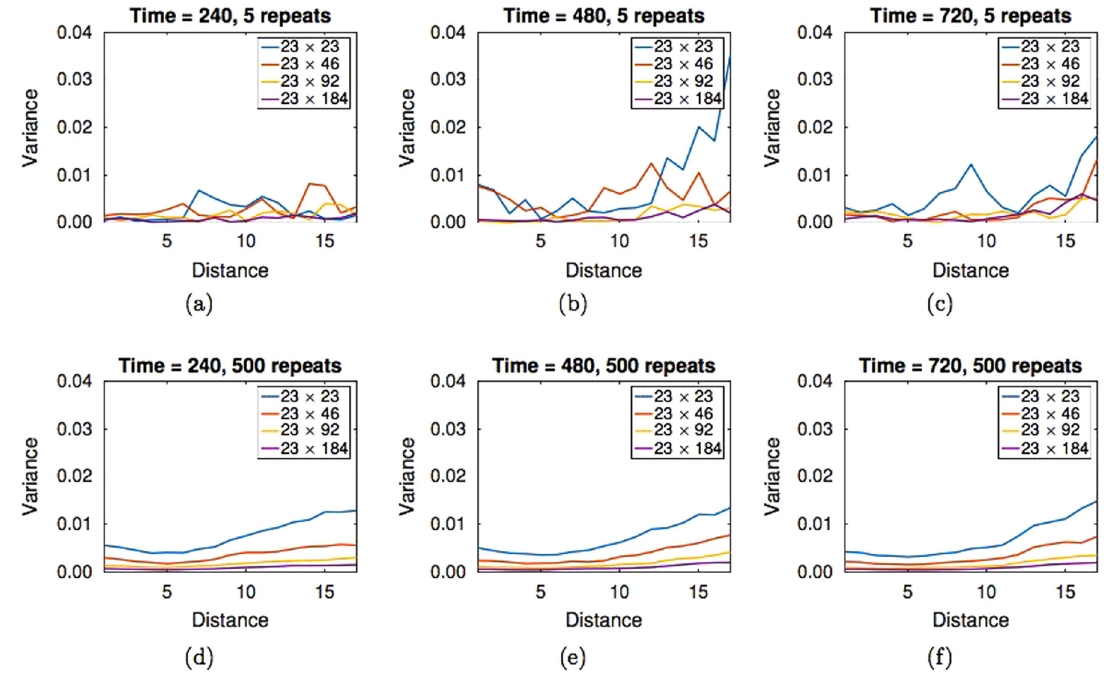
Fig. 4 The variance in the PCF synthetic data for model B with P m = 0.5 , α = 0.25 and different ABM domain sizes. Panels a – c display synthetic data generated from fi ve replicates of the ABM, panels d – f display synthetic data generated from 500 replicates of the ABM. The domain size is indicated in the